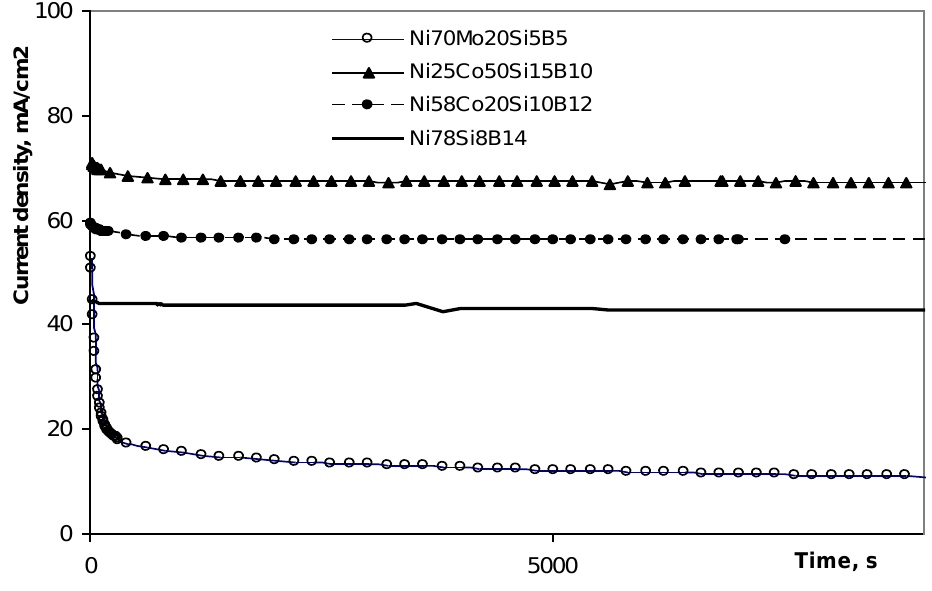
Figure 4. Polarization curves for four different Ni-containing metallic glasses in 1 M KOH at 25 ○ C in N atmosphere at an overpotential of 0.6 V toward the OER. 2